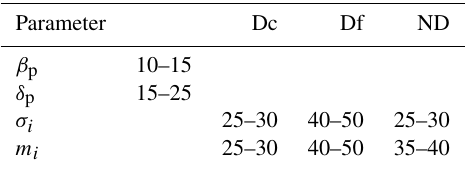
Table 2. Relative uncertainties (%) associated with the lidar-derived particle optical properties and mass features ( i is for the Dc, Df, and ND